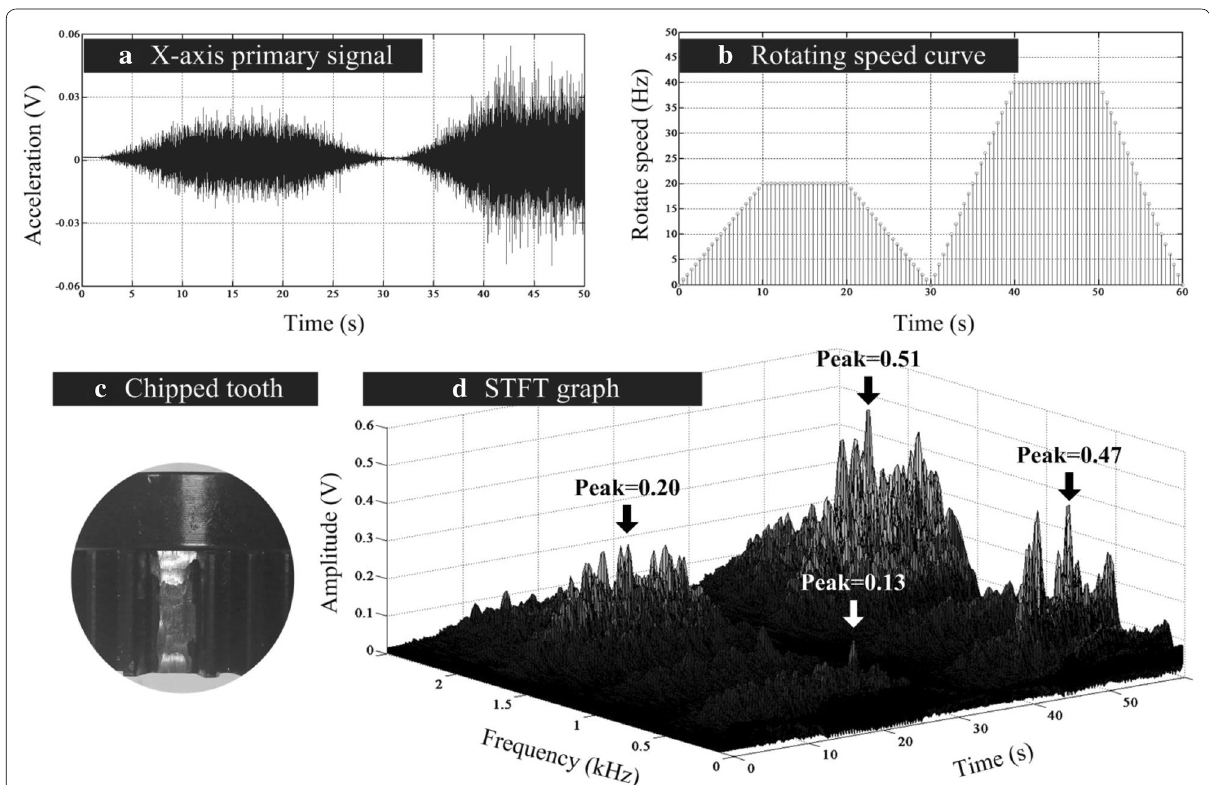
Figure 4 A STFT example for a chipped tooth signal with the Hamming window: a X -axis primary signal; b varying rotating speed curve; c fault gear with a chipped tooth; d the STFT graph